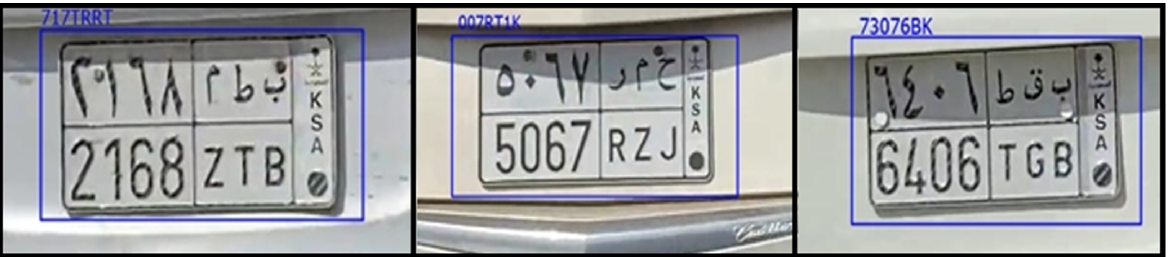
Figure 8. Initial results when the network was trained using only English text, but the plates also had Arabic text.